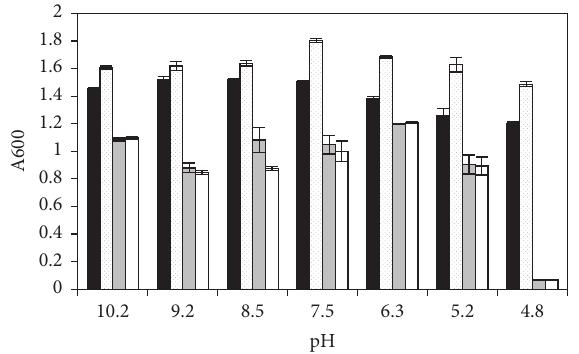
Figure 6: Effect of trehalose on the growth of wild type C. perfringens ATCC 13124 and mutant 13124 GR at different pH values. Black bars, wild type without trehalose; dotted bars, wild type with trehalose; gray bars, mutant without trehalose; white bars, mutant with